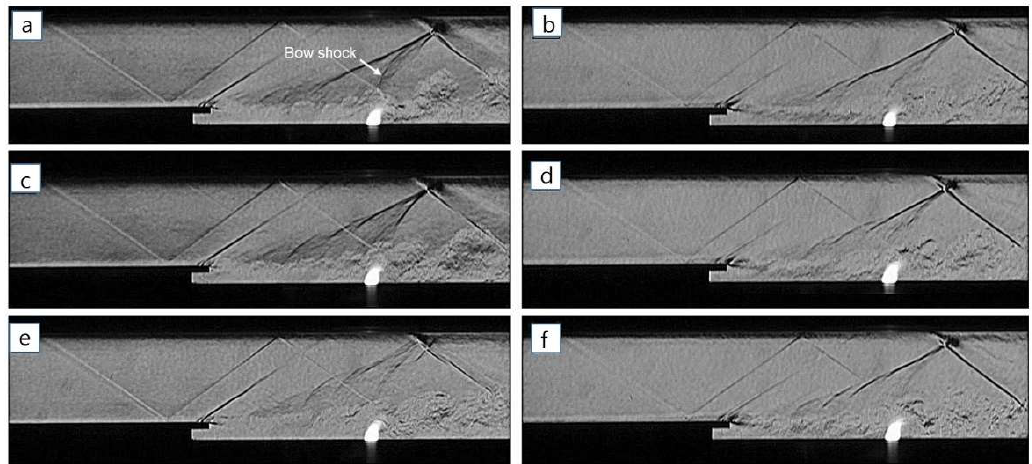
Figure 11. Combustion pressure distribution of the normal 2 injection for ER rise: VCM—vent circle mixer, VSM—vent slot mixer, ER—equivalence ratio.